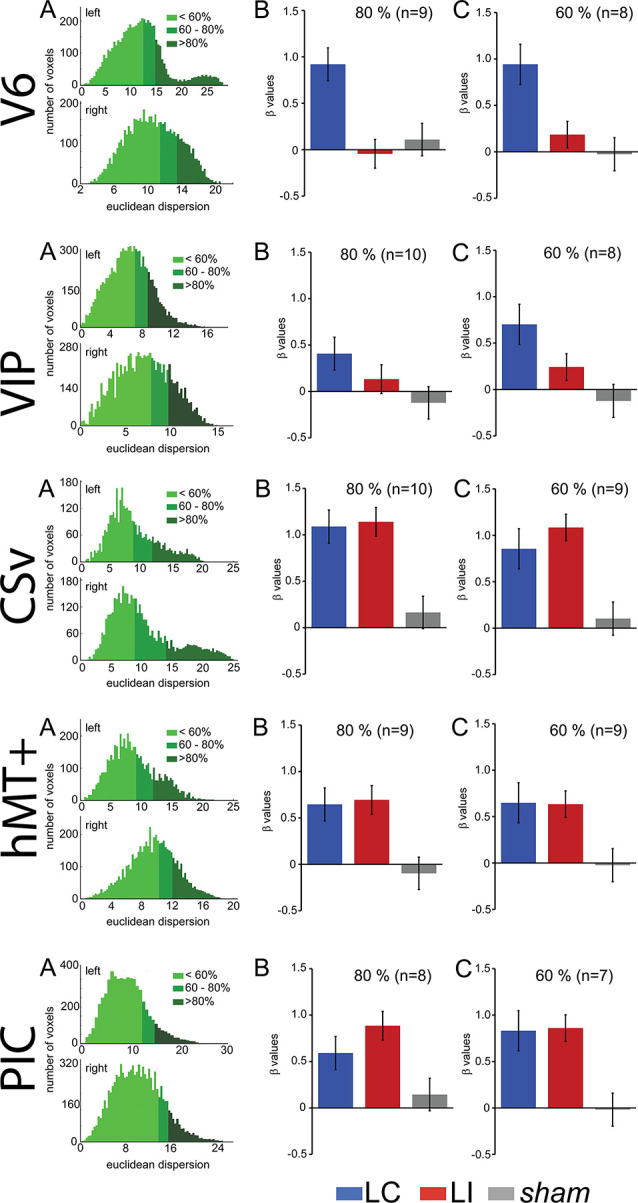
Control to characterize the influence of the ROI spatial extents on the results. These analyses were performed for V6, cingulate sulcus visual (CSv), hMT+, VIP, and PIC (from top to bottom). (A) Histograms showing the number of voxels within an ROI as a function of the Euclidean distance to the ROI centroid. The green colors give the repartition of 60%, 80%, and 100% closest voxels. (B) Bar graphs of the beta values for the two GVS conditions (AP, in blue and Lat, in red) and the sham stimulation. The analysis only included the 80% closest voxels to the centroid. (C) Idem for the 60% closest voxels.